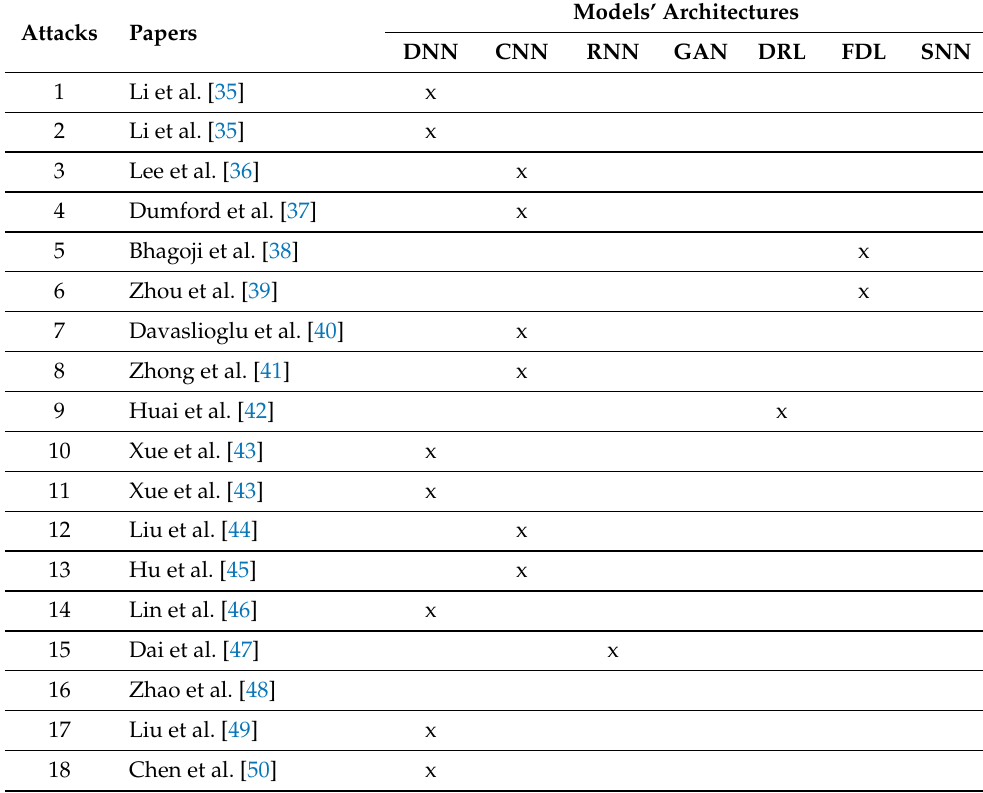
Table 7. A summary of model architectures for each